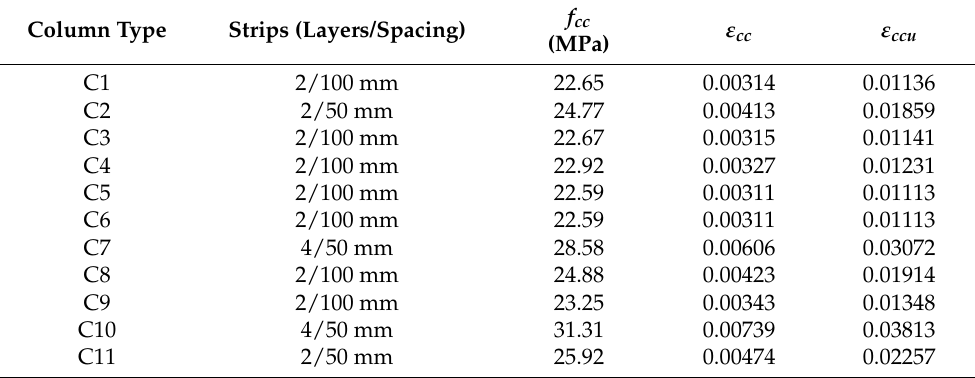
Table 1. Mechanical parameters of confined concrete—columns.